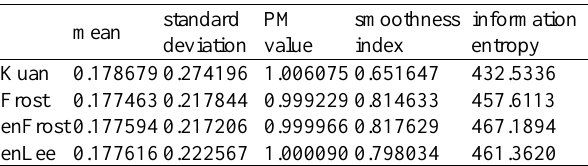
Table 1. Evaluation index of various filtering methods